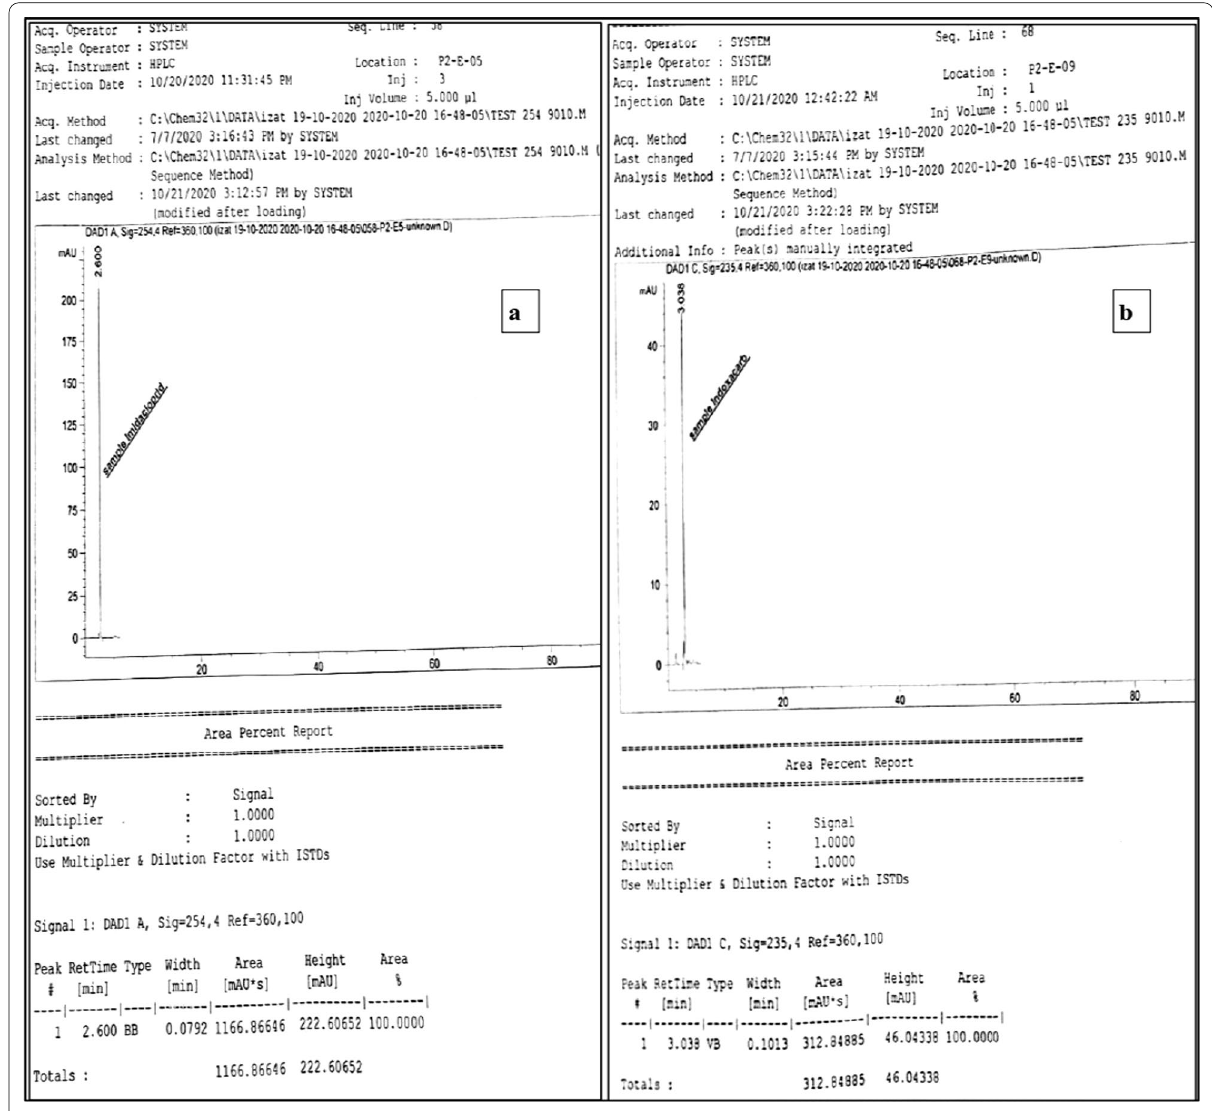
Fig. 4 Loading capacity of imidacloprid ( a ) and indoxacarb ( b